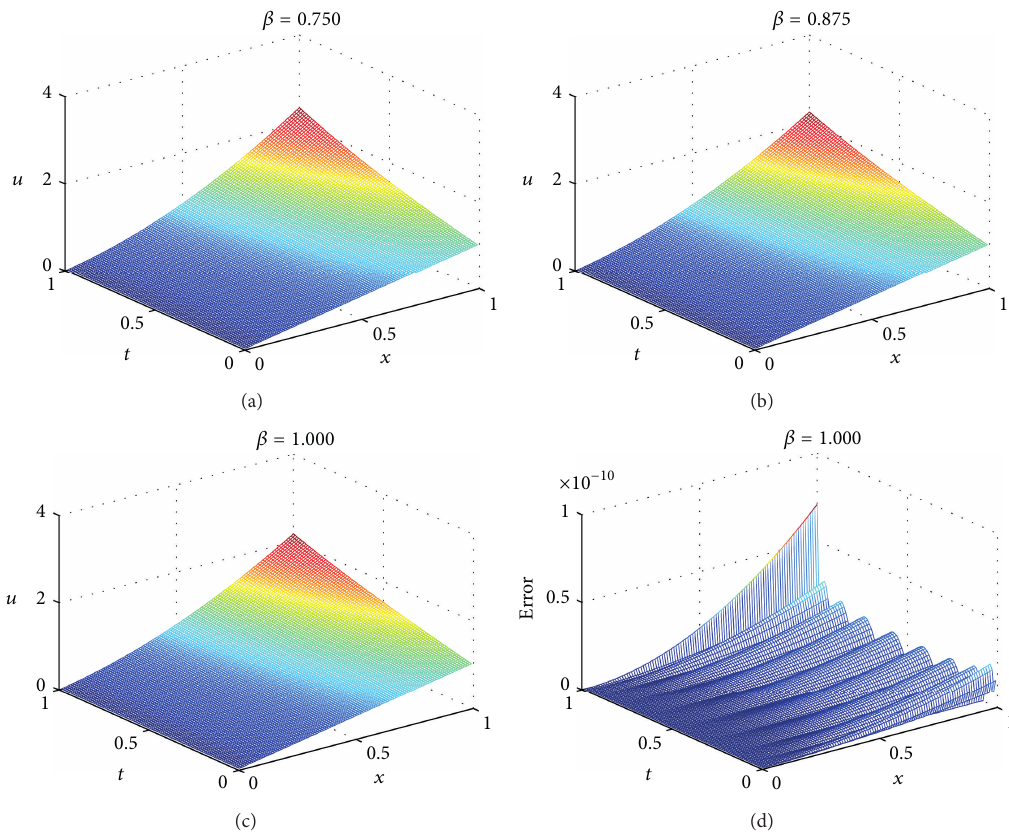
Figure 4: Numerical results of Example 26 for different value of 𝛽 .